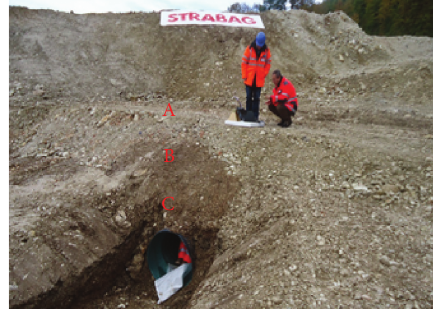
Figure 7: Test scenario: a victim is buried by 2 m of excavated ground.